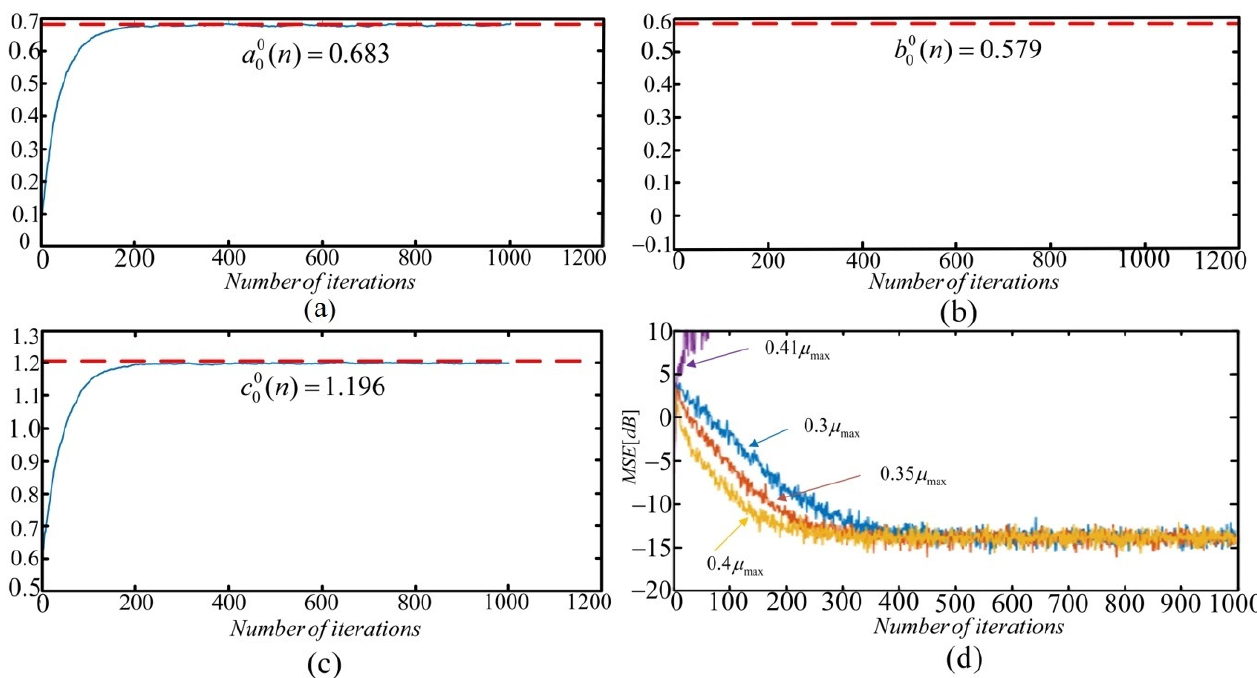
Figure 6. Convergence process of weight coefficients ( a – c ) and ANC system based on improved EE in different step factors ( d ).